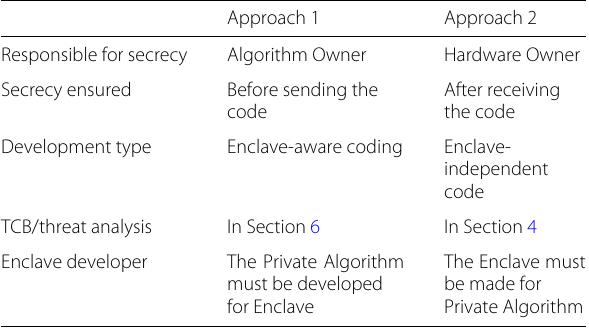
Table 2 Two approaches on secret-code execution through SGX